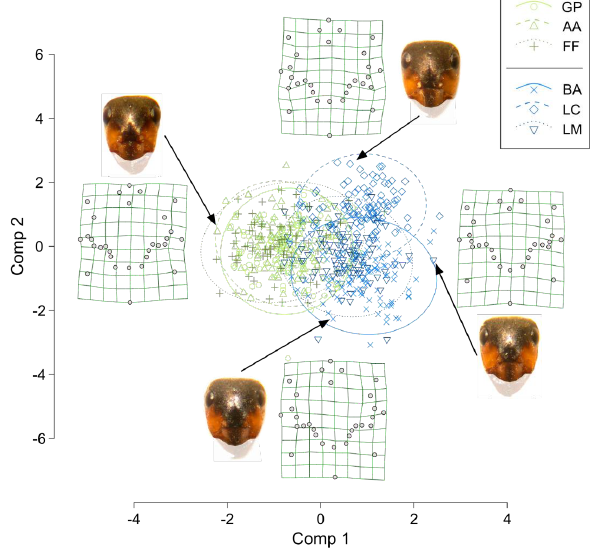
Figure 3. PLSDA global projection of relative warps from the facial coloration landmarks. Green grids are examples of thin-plate spline representations of four samples selected at the border of the PLSDA projection, so that they show the differences in the shape of facial coloration according to the two components. Samples are indicated by the arrows, and the picture of their face is reported aside their thin-plate spline representation. The same colored and shaped symbols are samples from the same population, and ellipses represent the 95% C.I. of each population. In the thin-plate spline grid representations, points are both landmarks and semi-landmarks (see Figure 2 for details). GP = Giovetto di Paline, AA = Avorniolo Alto; FF = Fosso Fresciaio; BA = Baradello; LC = Le Cullacce; LM = La Lama. GP and BA are the Alpine native sites.